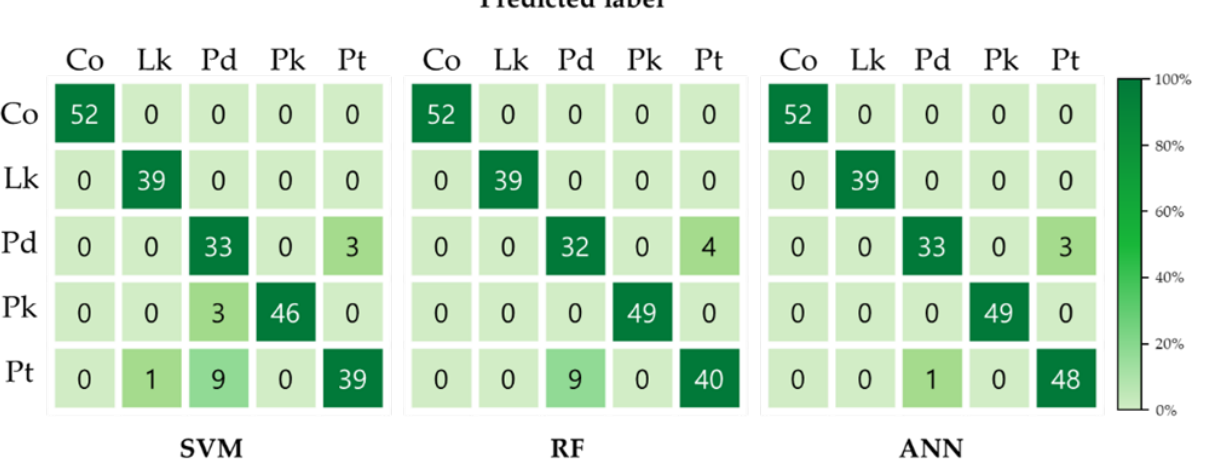
Figure 5. Confusion matrix for the three machine learning models. The x-axis represents the label predicted by the models, and the y-axis represents the true label. Cells are color-coded by accuracy percentage. The genus-level classification accuracy was 100% in all models.